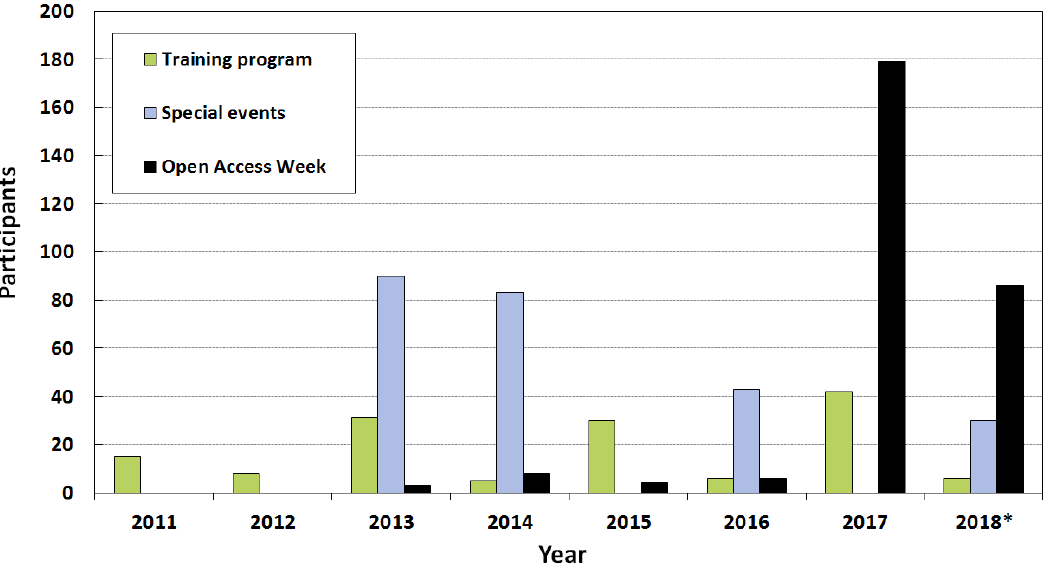
Figure 3. Number of participants in open-access-relevant training courses (green), events (blue)